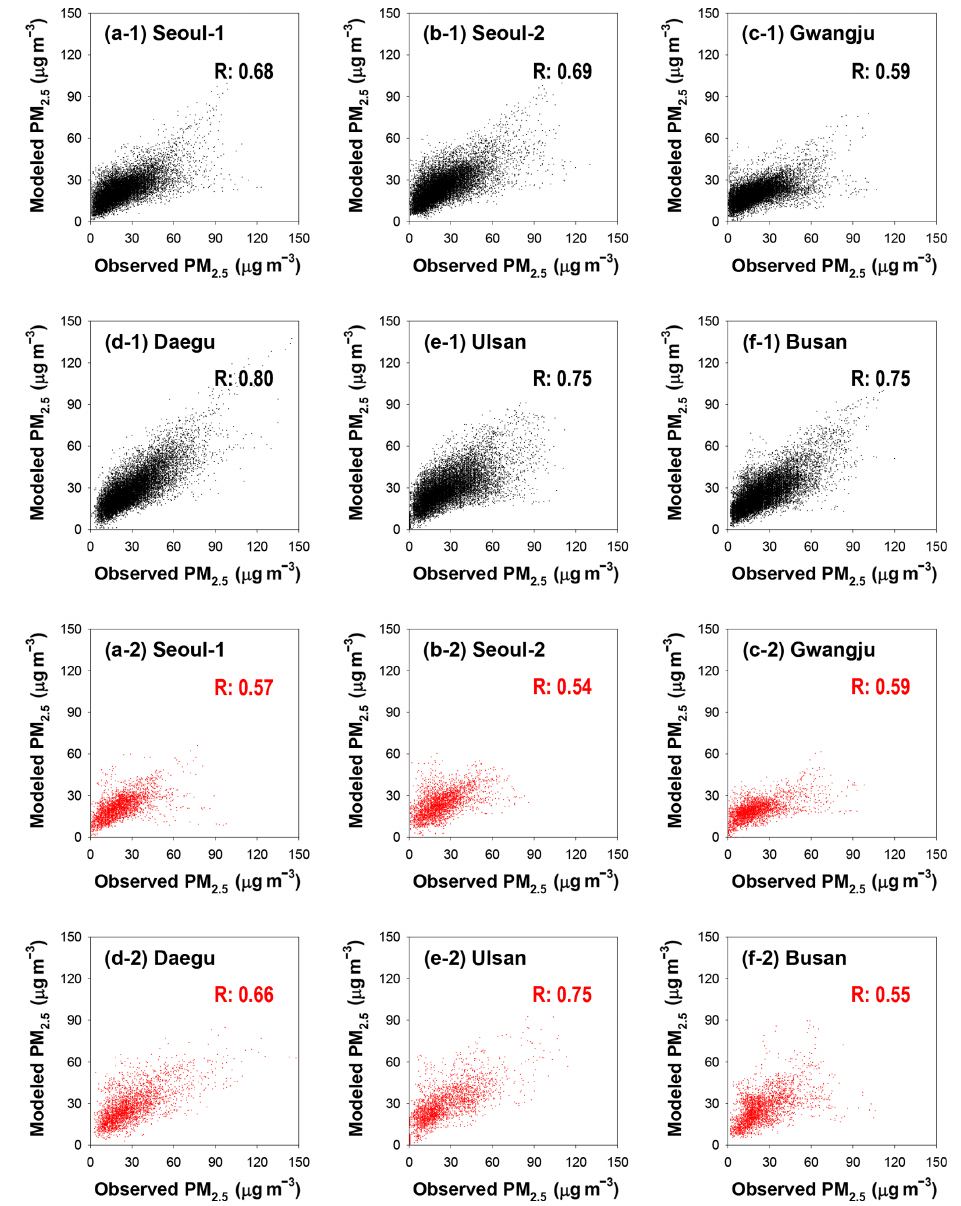
Figure 4. Same as Fig. 3 but for PM 2 . 5